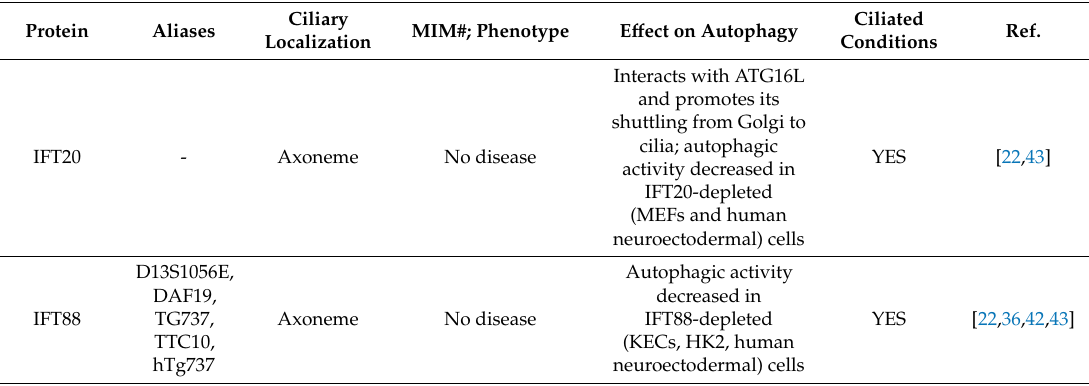
Table 1. Proteins involved in the control of both ciliogenesis and